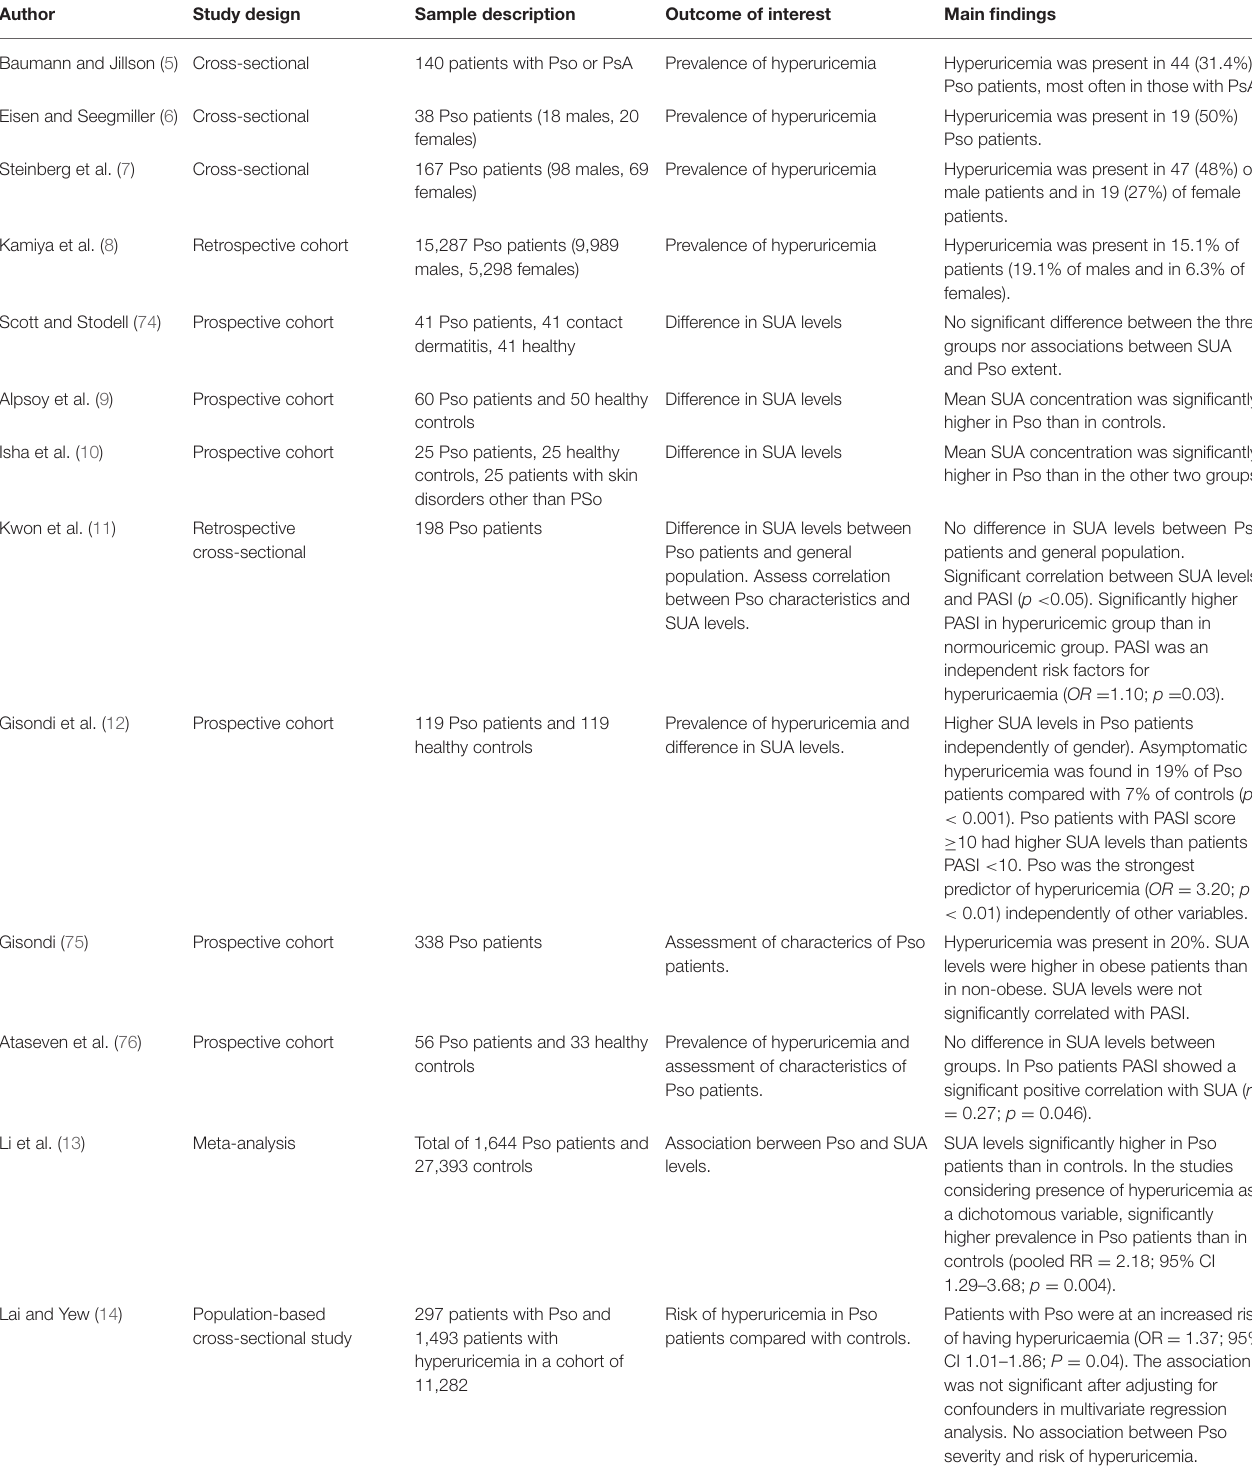
TABLE 1 | Characteristics of studies included in the evaluation of the association between serum uric acid levels and psoriasis or psoriatic